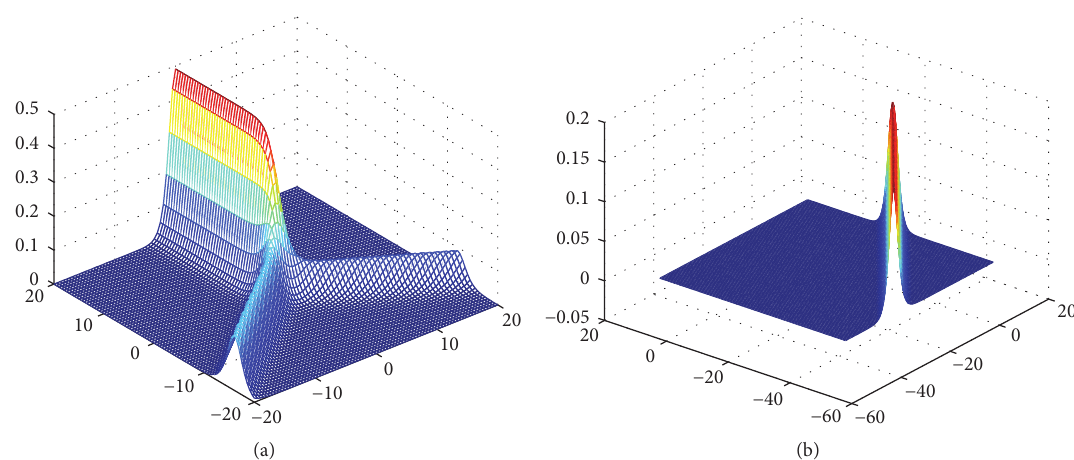
Figure 6: The resonant solution to (9) with the parameters 𝑘 1 = 0.6 , 𝑘 2 = 0.8 , 𝑙 1 = 𝑙 2 = 1 , and 𝑎 1 = 𝑎 2 = 0.